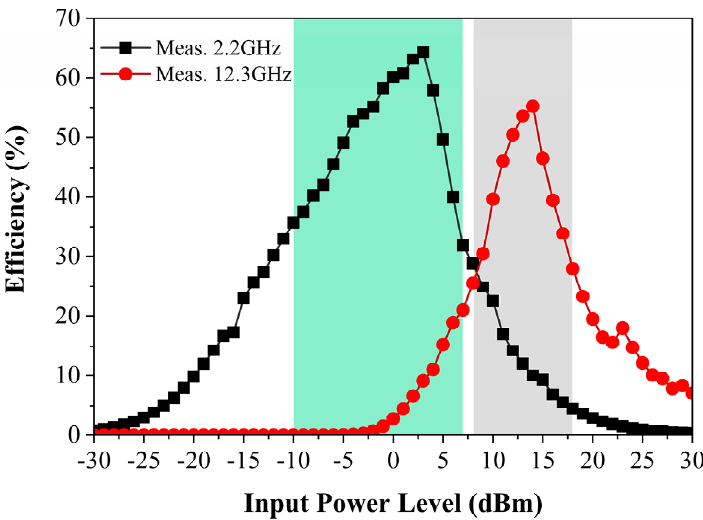
Figure 14. Measured RF-to-dc efficiency of the proposed metasurface array versus input power levels at 2.2 GHz and 12.3 GHz. Table 1. Comparison of the proposed metasurface array with related